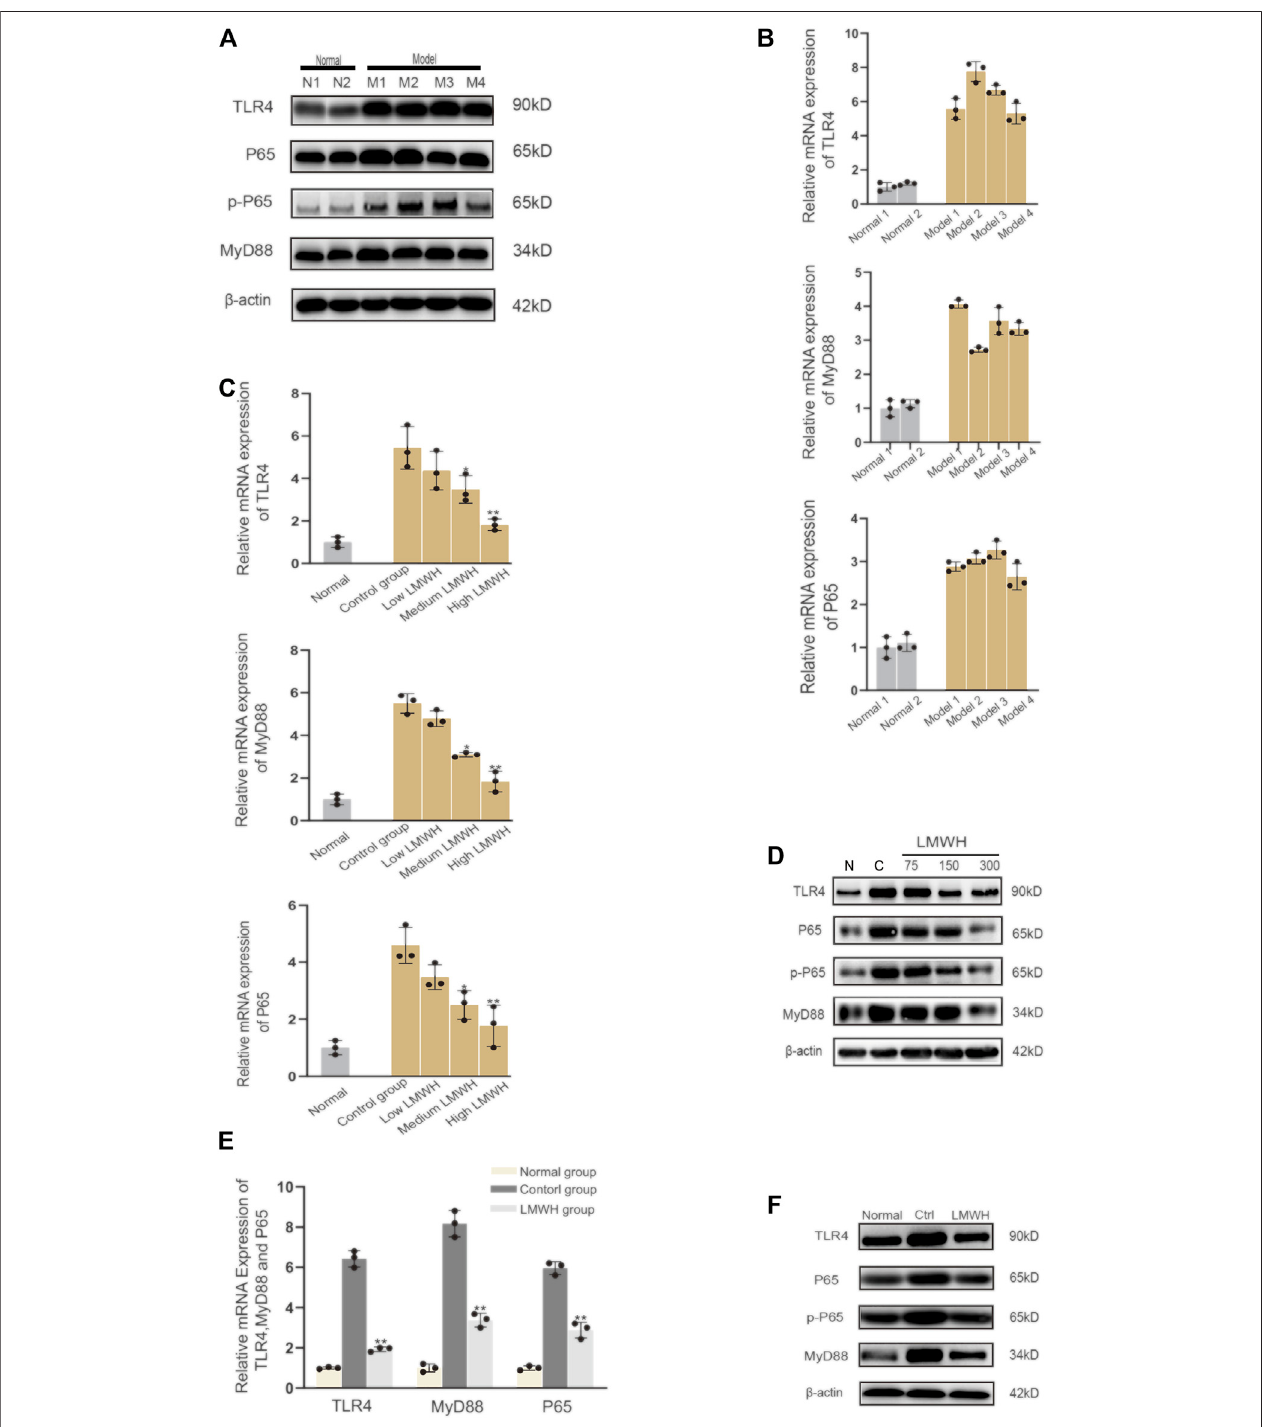
FIGURE 4 | LMWH suppressed the activation of the TLR4-MYD88-NF- κ B signaling pathway. (A) Expression of TLR4-MYD88-NF- κ B pathway-related proteins in normalrats and modelrats byWestern blot. (B) Relative mRNA leveloftheTLR4-MYD88-NF- κ Bpathway-related genesinnormal ratsand model ratsbyRT-qPCR. (C) Relative mRNA level of TLR4-MYD88-NF- κ B pathway-related genes in normal rats, experimental control rats, and rats injected subcutaneously with different concentrations of LMWH by RT-QPCR. (D) Expression of TLR4-MYD88-NF- κ B pathway-related proteins in the normal rats, experimental control group rats, and rats injected subcutaneously with different concentrations of LMWH by Western blot. (E) Relative mRNA level of TLR4-MYD88-NF- κ B pathway-related genes in normal rats, experimental control group rats, and rats whose nose cavity was irrigated with saline mixed with high dose LMWH by RT-QPCR. (F) Expression of TLR4-MYD88- NF- κ Bpathway-relatedproteinsinnormalrats,experimentalcontrolrats,andratswhosenosecavitywasirrigatedwithsalinemixedwithhighdoseLMWH(300 u/kg)by Western blot. Note: *compared with control group p < 0.05. **compared with control group p < 0.01; The experiment was repeated three times.